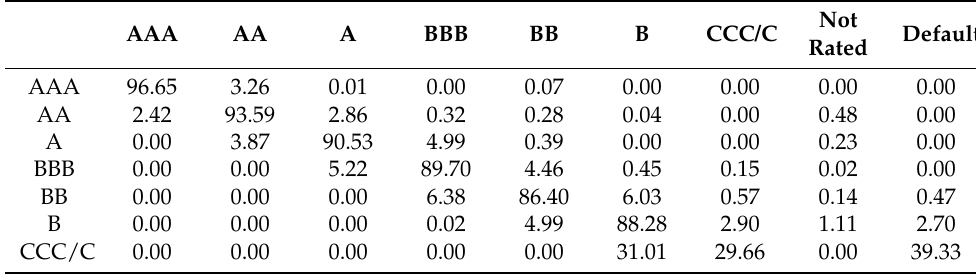
Table 1. Global one-year average transition probabilities of sovereign ratings in foreign currency (1975–2019, in